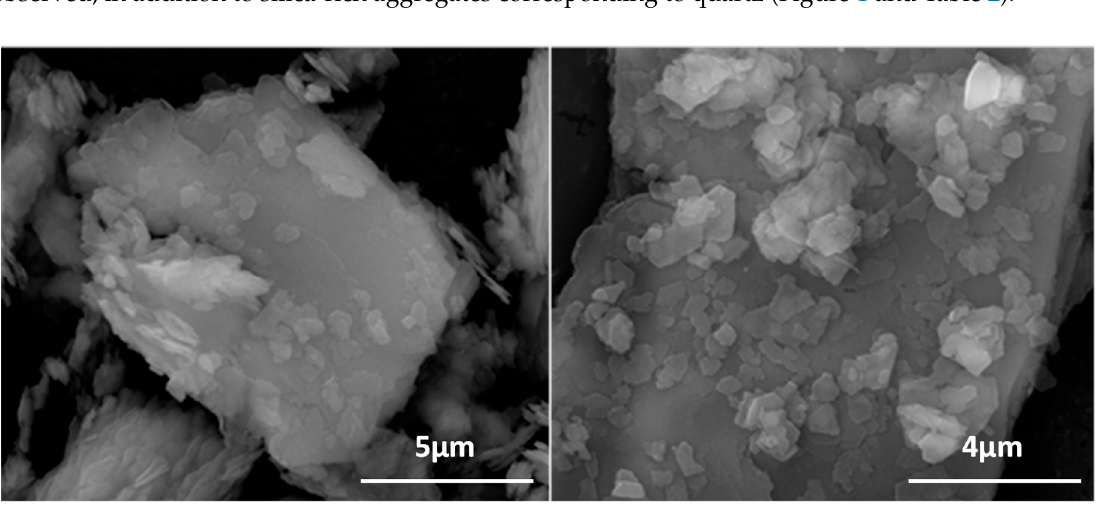
Figure 1. Kaolinite (left) and mica (right) crystals: superficial appearance.